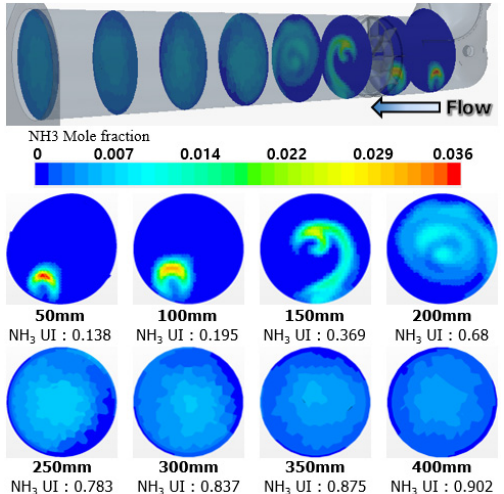
Figure 10. Development of ammonia uniformity after a urea injection point and the cross-sectional views and UI values at specific distances: from 50 mm to 400 mm with 50 mm intervals.